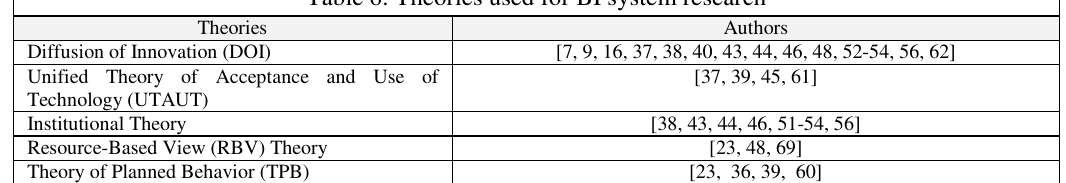
Table 6: Theories used for BI system